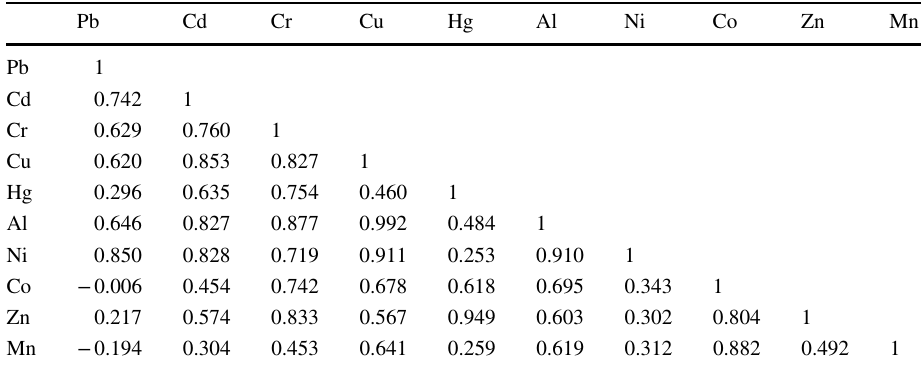
Table 4 Correlation matrix of heavy metals in water